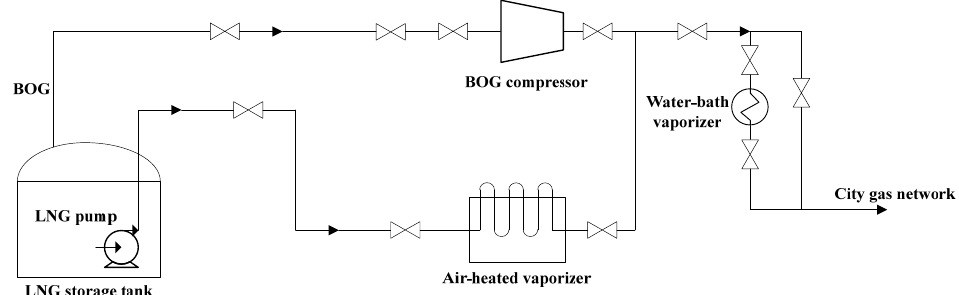
Figure 4. Schematic diagram of the process flow of LNG vaporizing station.